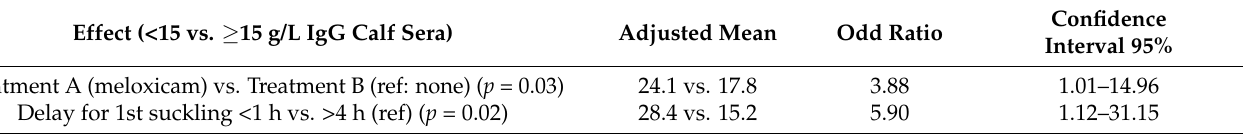
Table 5. Results of the final model for logistic regression investigating the likelihood of having an IgG level above or below 15 g/L in calf sera 24–48 h after birth. Effect (<15 vs. ≥ 15 g/L IgG Calf